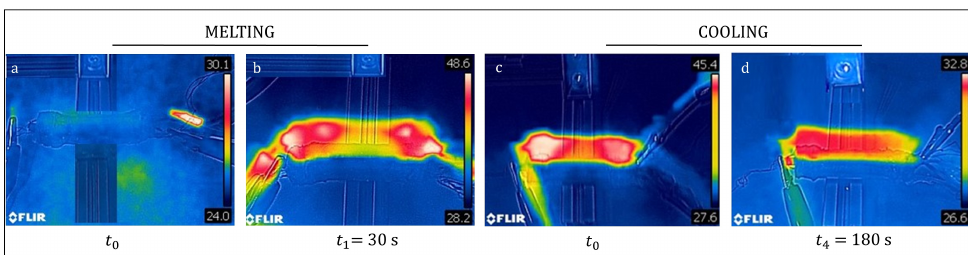
Figure 8. Experimental results for the maximum force supported by the LMPA device during the transition ( a ) from the stiff to the soft state and ( b ) from the soft to the stiff state.